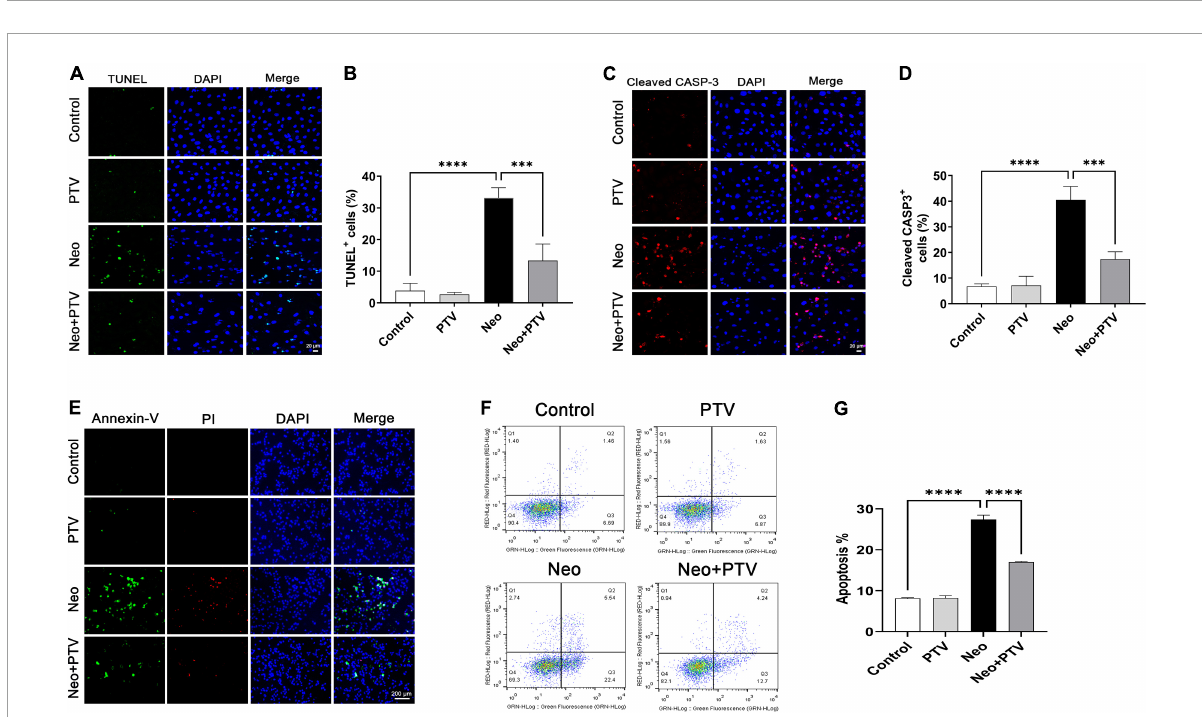
FIGURE3 Effects of PTV on neomycin-triggered HEI-OC1 cell apoptosis. (A,C) TUNEL staining and cleaved CASP-3 immunostaining of HEI-OC1 cells. Scale bars = 20 µ m. (B,D) Statistics of the proportions of TUNEL or cleaved CASP-3 highlighted HEI-OC1 cells in (A,C) ( n = 3). (E) Annexin-V/PI staining in PTV and neomycin treatment HEI-OC1 cells. Scale bars = 200 µ m. (F) Apoptosis detection of HEI-OC1 cells by flow cytometry. (G) Statistics of the proportions of apoptotic HEI-OC1 cells in different groups ( n = 3). ∗∗∗ p < 0.001, ∗∗∗∗ p <